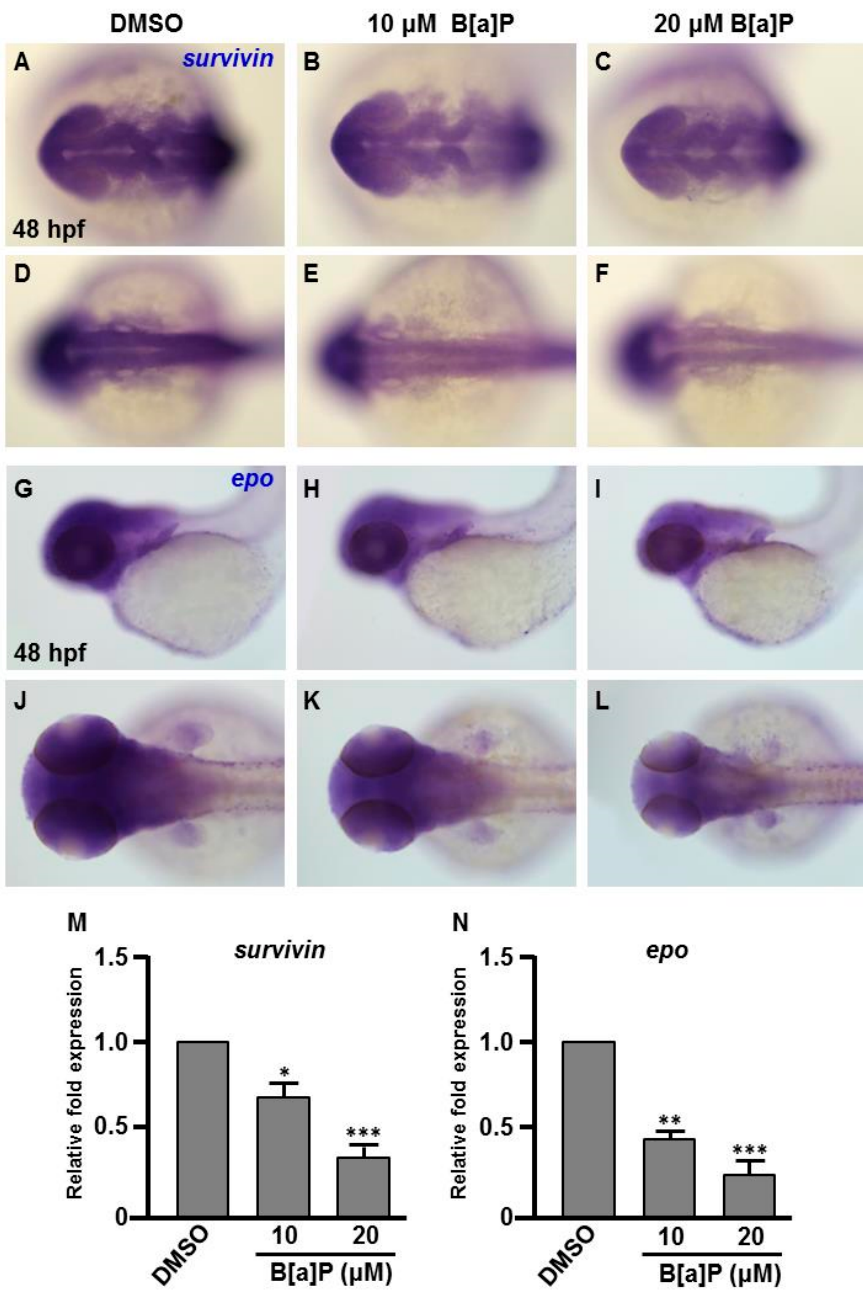
Figure 6. Expression levels of Survivin and Epo genes are reduced in B[a]P treated embryos. Zebrafish were exposed to 0 µ M (control, 01% DMSO), 10 and 20 µ M of B[a]P from 2 hpf until 24 hpf. Whole-mount in situ hybridization staining was performed with riboprobes against survivin ( A – F ) and epo ( G – L ) at 24 hpf. The staining levels of survivin ( M ) and epo ( N ) were quantified. * p < 0.05, ** p < 0.01, *** p < 0.001 compared to control.